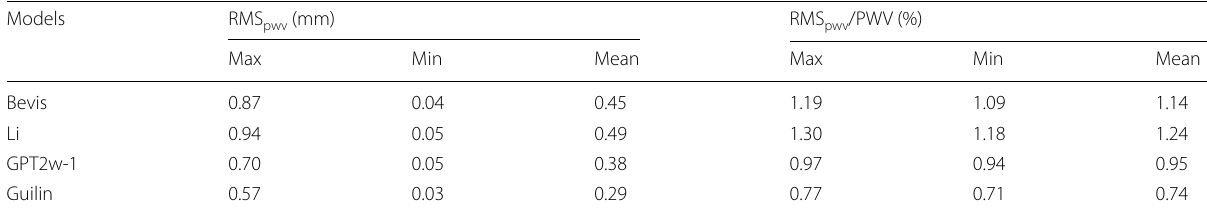
Table 3 Statistical results of theoretical RMS and relative errors in PWV resulting from the four models validated by using radiosonde profiles from 2017